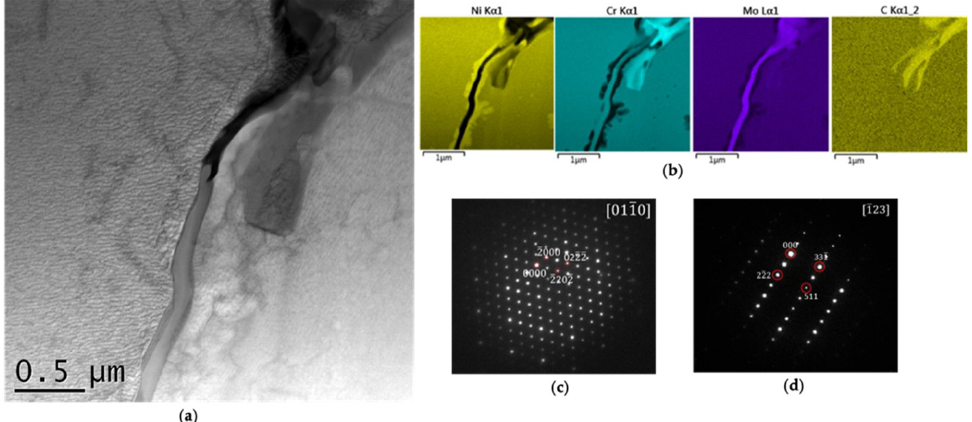
Figure 5. Identification of grain boundary precipitates: ( a ) a micrograph showing white and dark precipitates on a grain boundary, ( b ) EDS maps showing the white precipitate and the dark precipitate, ( c ) diffraction of the white precipitate and ( d ) diffraction pattern of the dark precipitate.